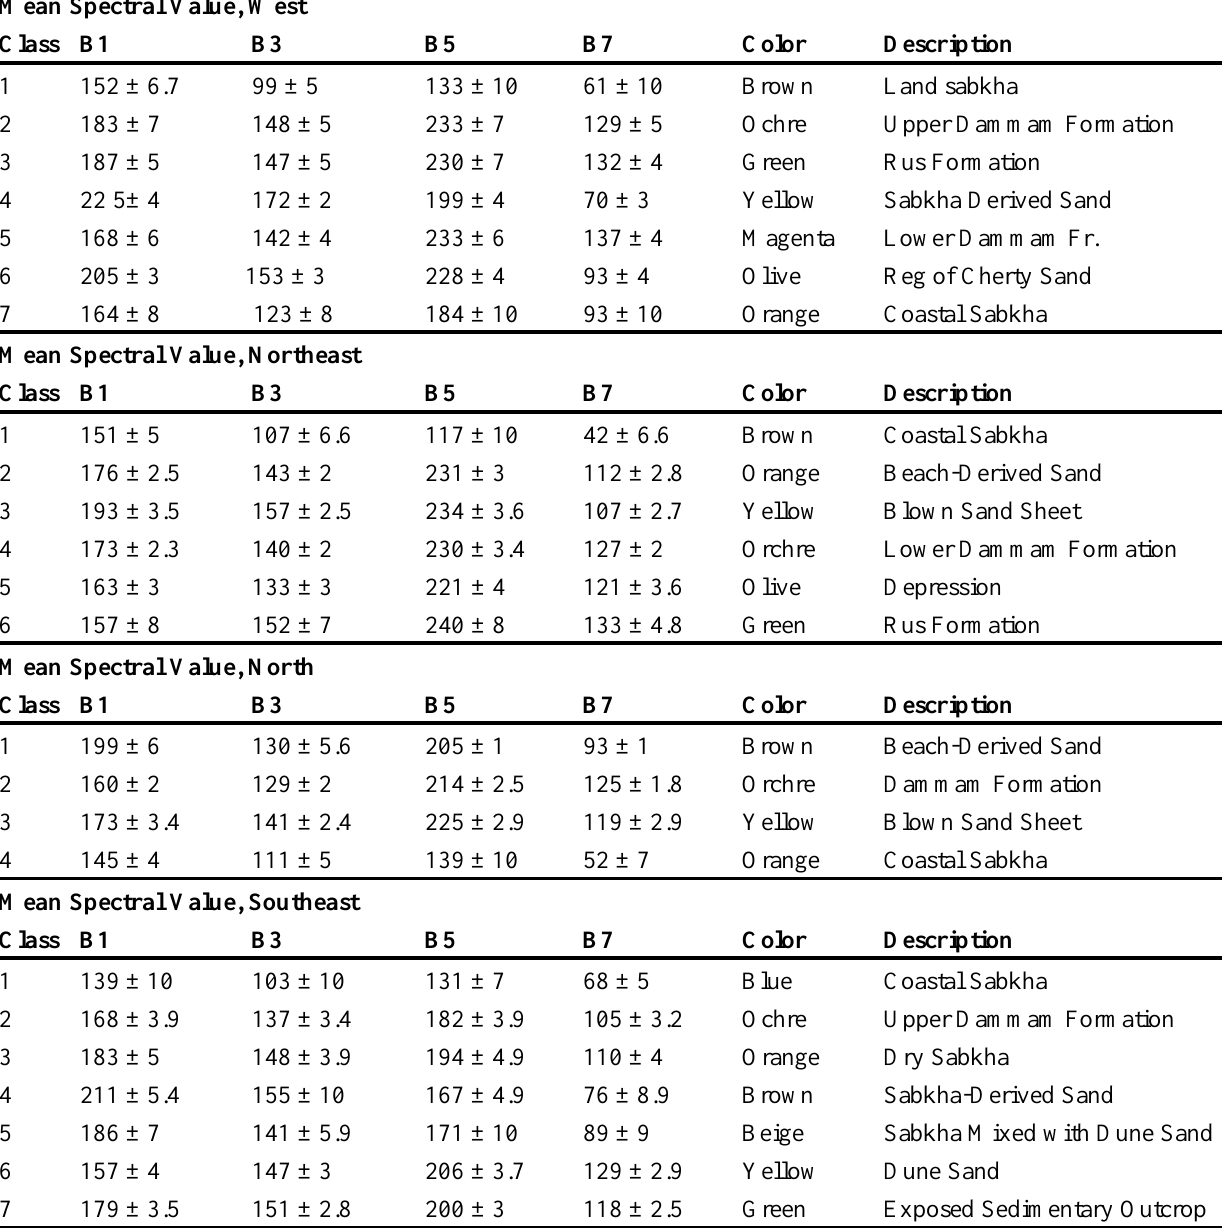
Table 2. Class descriptions and mean spectral values of each class within non-thermal Landast TM bands of west, northeast, north tip and southeast of Qatar